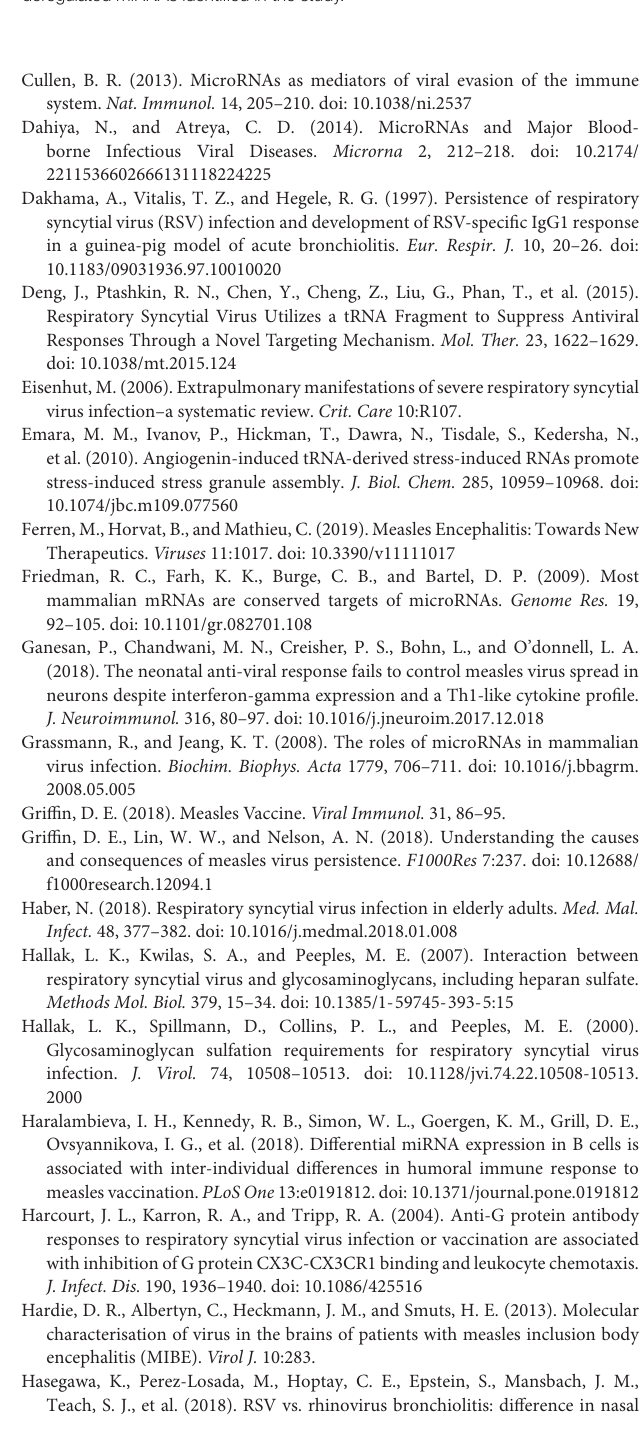
Supplementary Table 1 | MiRNA modification data patterns in RSV and MeV infected neuronal cells. Table lists samples, microRNAs, type of modifications, modification site, pattern, modification position, internal modification type, internal modification position, repeat modifications and counts of modifications for all deregulated miRNAs identified in the